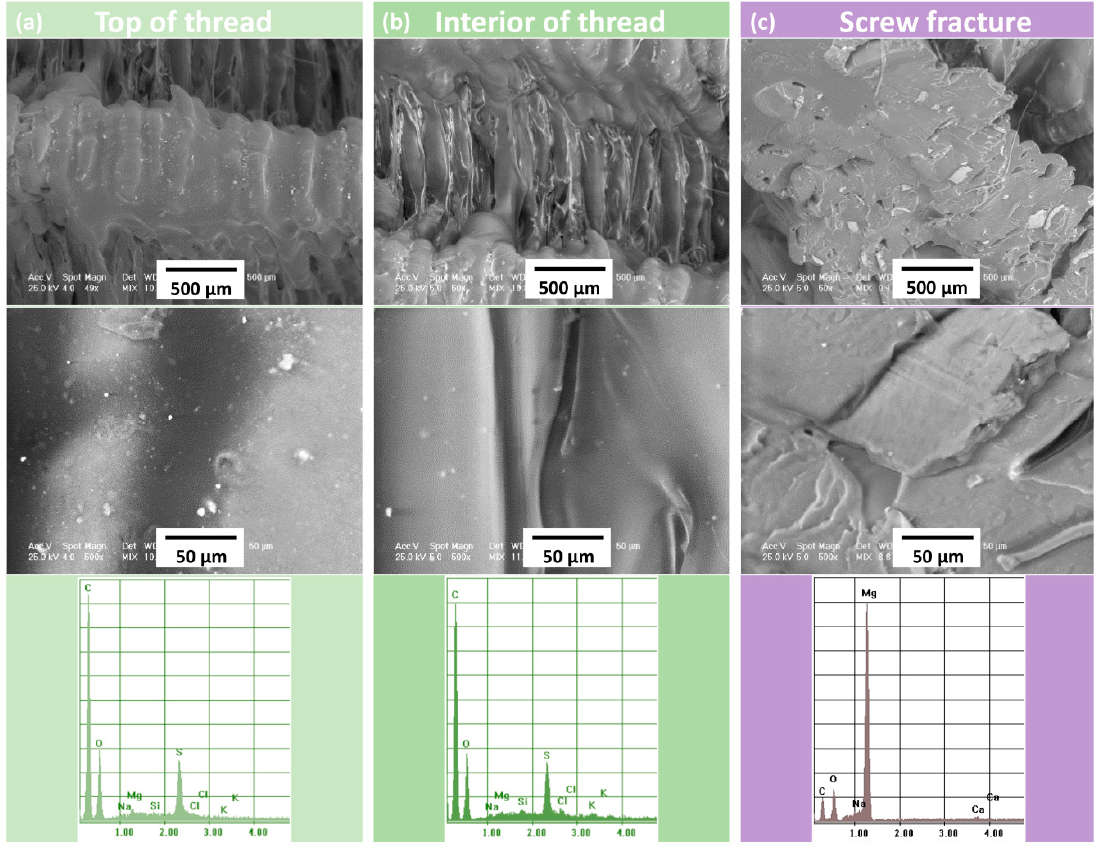
Figure 8. Representative results of SEM and EDS analysis: ( a ) analysis on the top of screw, ( b ) analysis of the Mg particle embedded in PLA matrix, ( c ) transverse screw fracture after immersion in liquid nitrogen;